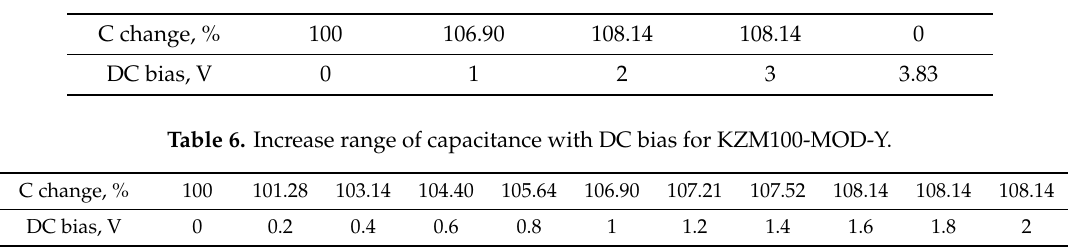
Table 5. Full range of capacitance change with DC bias for BT02-MOD-Y.